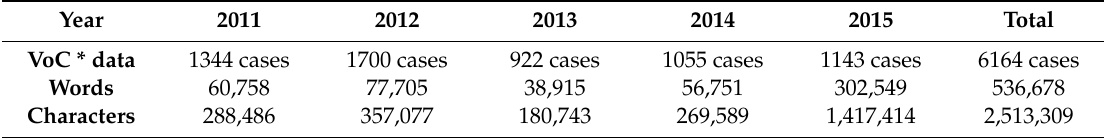
Figure 1. Data attribute graph. Table 1. Data attributes (* Voice of